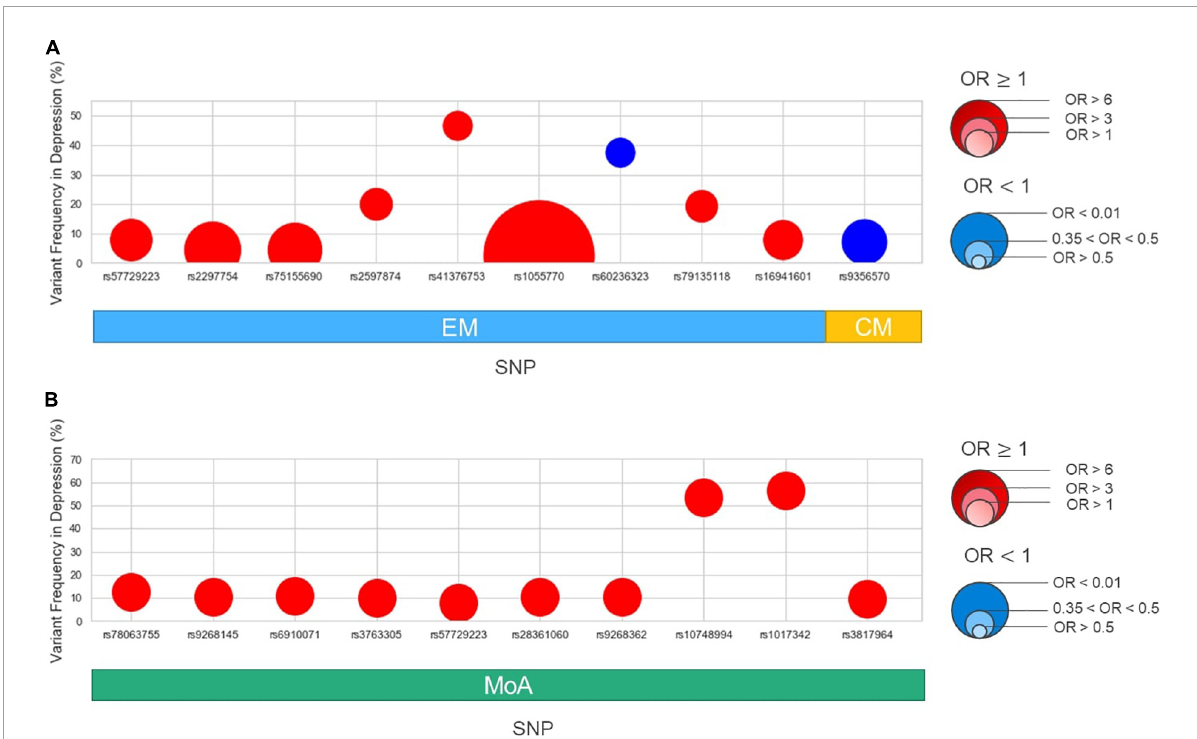
FIGURE3 Variant frequency and odds ratio in subgroups: episodic migraine (EM), chronic migraine (CM), aura (MA), and non-aura (MoA). The x-axis shows the variants identified in this study, subgrouping into EM/CM (A) and MA/MoA (B) as in Table 2 . The y-axis shows the variant allele frequency in the depression group. The size of dots is based on the odds ratio. Red in each point denotes OR > 1, while blue denotes OR <